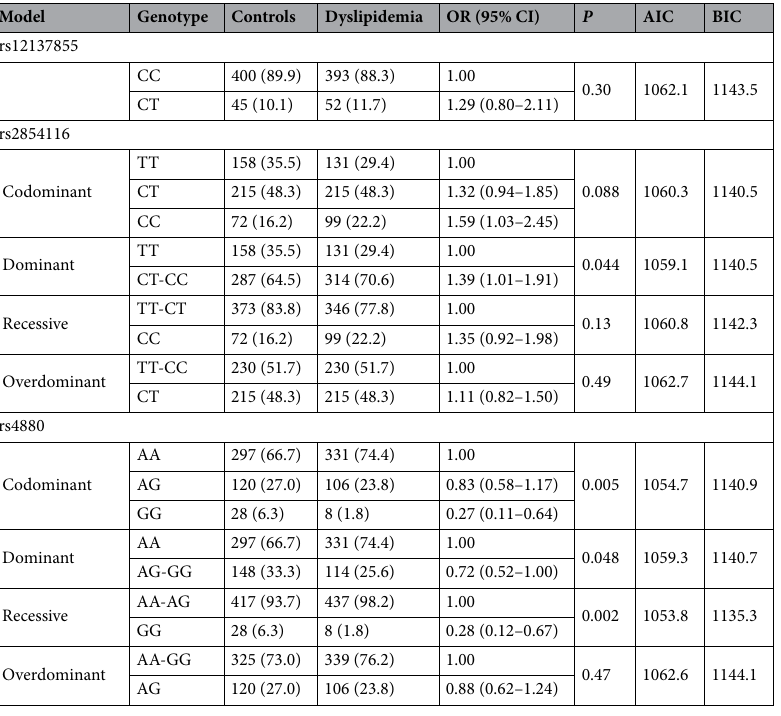
Table 5. Association analysis of each gene polymorphism and dyslipidemia (n[%]). Adjusted variables included: smoking status, drinking status, DASH diet score, physical activity level, sleep quality, BMI, hypertension, HUA, shift work situation, and OS.